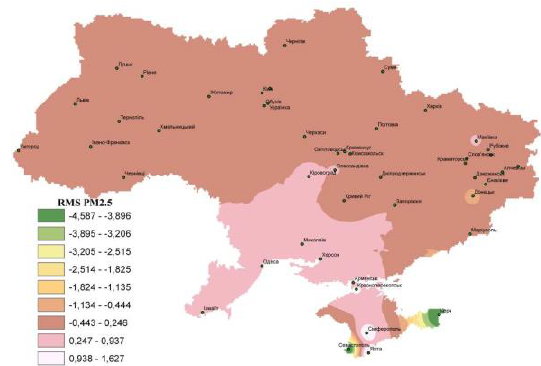
Figure 5. Distribution RMS deviation for geographically weighted regression